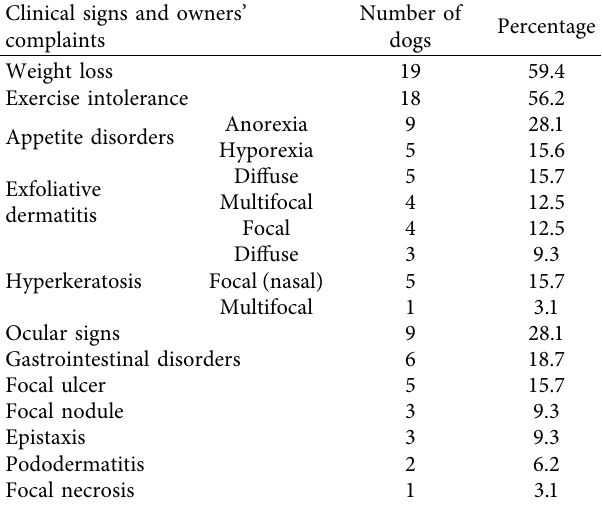
Table 1: Main clinical signs and complaints mentioned by the owners for the 27 dogs with